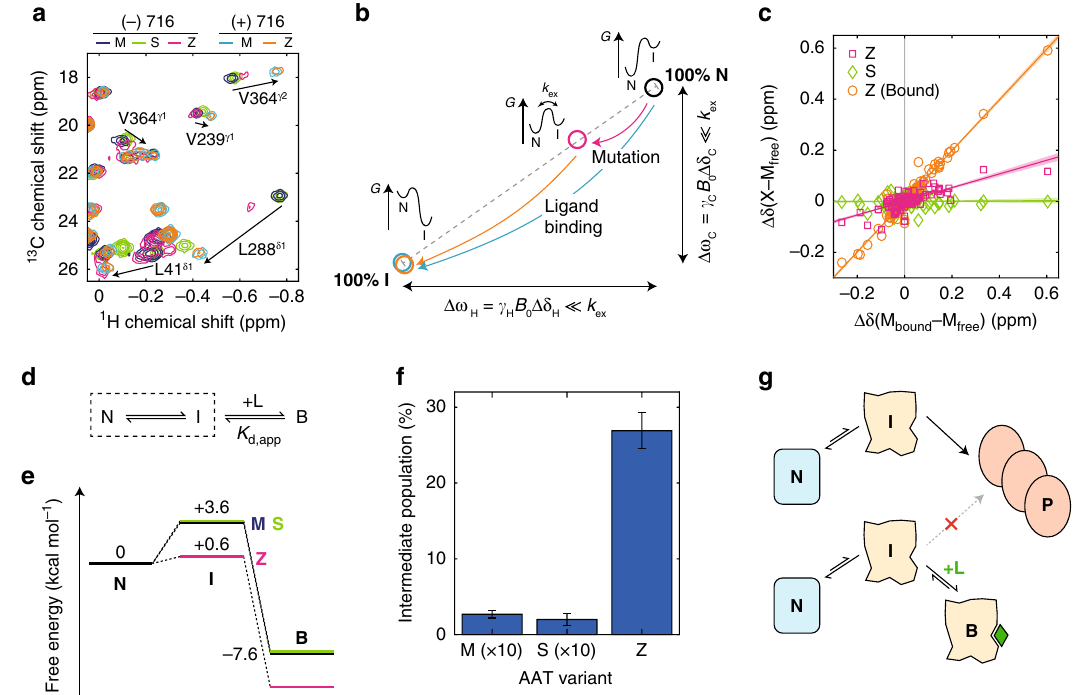
Fig. 7 Quanti fi cation of intermediate populations in ex vivo AAT variants. a Overlays of 1 H, 13 C SOFAST-gHMQC spectra (isoleucine region) for free M (blue), Z (magenta) and S (green) AAT, and 716-bound M (cyan) and Z (orange) AAT, with selected resonance attributions and colinear chemical shift perturbations indicated. Contour levels are normalised for concentration and acquisition time. b Schematic illustration of the origin of collinear chemical shift perturbations, arising from a rapid equilibrium between native (N) and intermediate (I) states. c Chemical shift perturbations of AAT resonances relative to wild-type M AAT, plotted against chemical shift changes in M AAT upon 716 binding. Lines of best fi t through the origin are shown. 1 H and 13 C chemical shift differences are plotted independently and 13 C measurements have been scaled by a factor of 0.25. Resonances near sites of mutation or 716 binding showing evidence of local perturbations to their chemical environment have been excluded from this analysis. d The conformation selection reaction scheme. A dotted box highlights the intramolecular equilibrium, while the apparent dissociation constant of the ligand is determined relative to the total concentration of unbound species, K d ; app ¼ ð½ N (cid:2) þ ½ I (cid:2)Þ = ½ B (cid:2) . e Free-energy diagram of AAT showing native (N), intermediate (I) and 716-bound (B) states under standard conditions. f Populations of the intermediate state in wild-type and variant AAT. Error bars indicate the standard error determined from fi ts. g Cartoon illustration of the inhibition of AAT misfolding and polymerisation (P) via the binding and stabilisation of an on-pathway intermediate state by a small-molecule ligand. Source data are provided as a Source Data fi